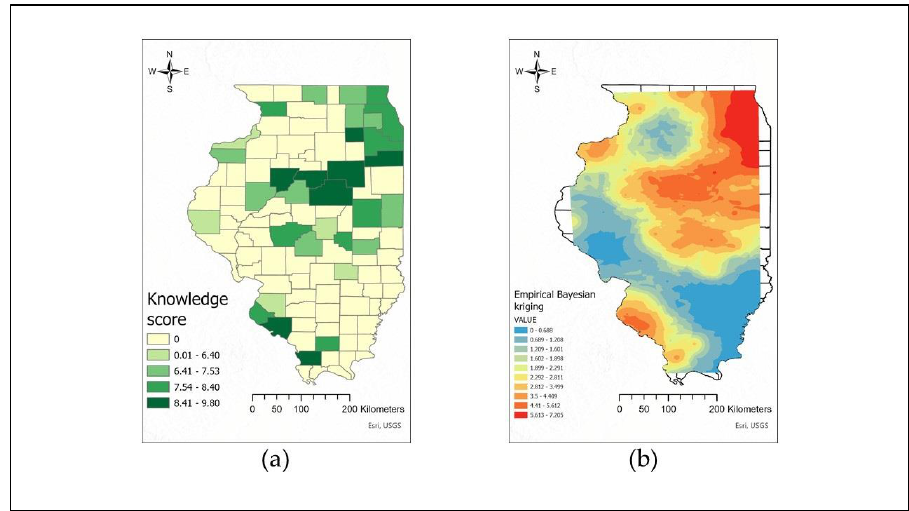
Figure 5. Choropleth map of the survey knowledge scores ( a ). Isopleth map of knowledge scores applying spatial interpolation by using empirical Bayesian kriging ( b ).